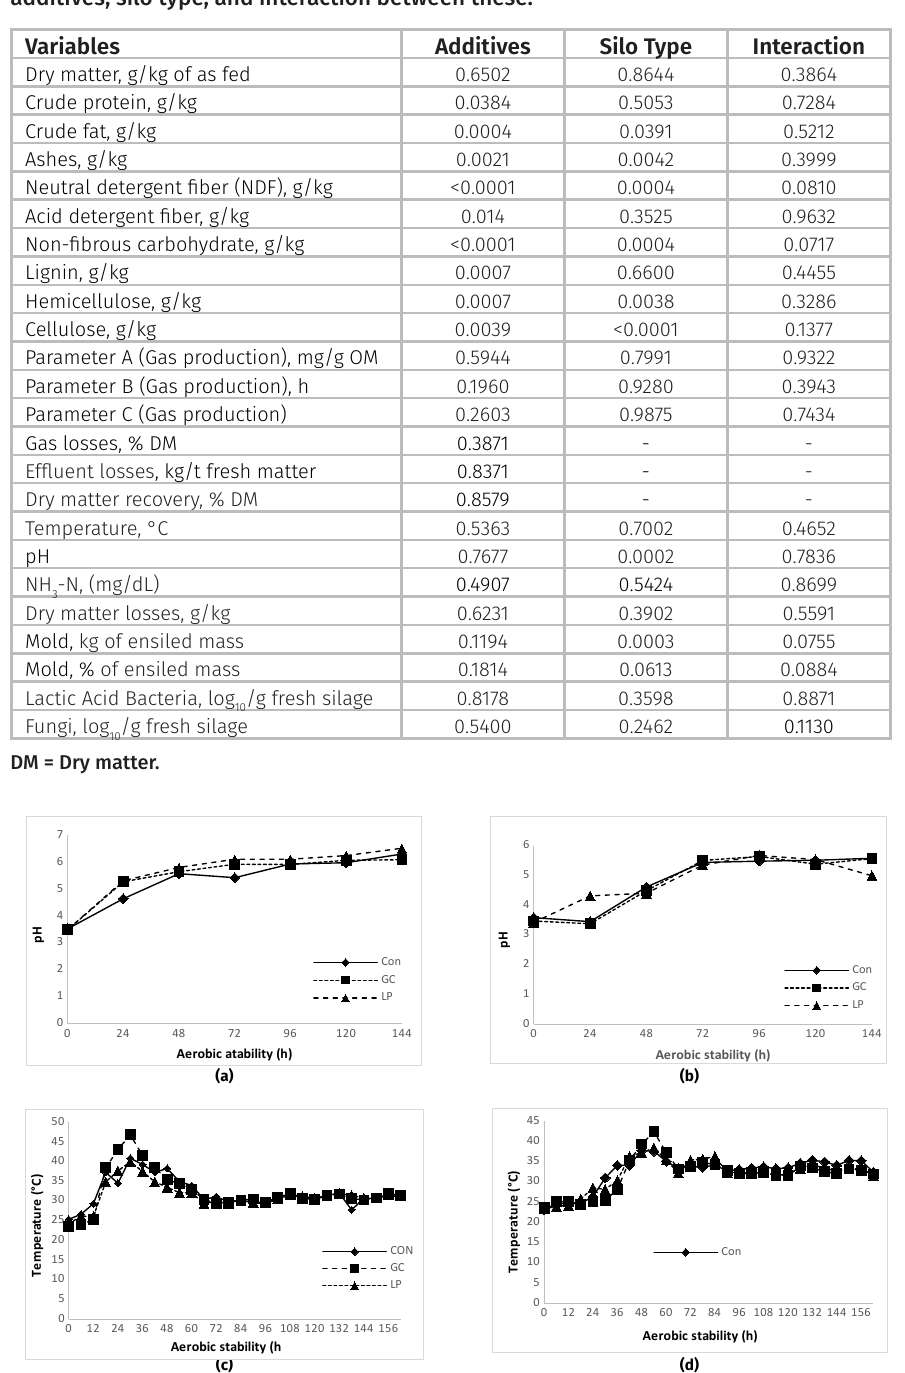
Figure 2. pH and temperature values of pearl millet silage with different additives and ensiling methods for seven-days. CON = Control; GC = Ground corn; LP = Lactobacillus plantarum (2.5 × 10 10 cfu/g) and Propionibacterium acidipropionici (2.5 × 10 10 cfu/g); Bag = Silo Bag (51 × 110 cm and 200 micras); PVC = Polyvinyl chloride. On panel (2a) Bag; (2b) PVC; (2c) Bag; and (2d)